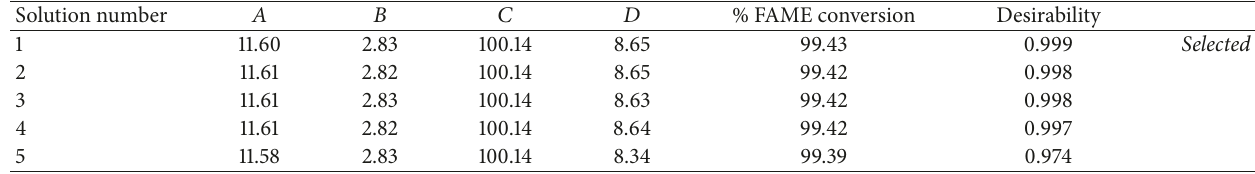
Table 4: Numerical optimization of the reaction conditions using RSM.